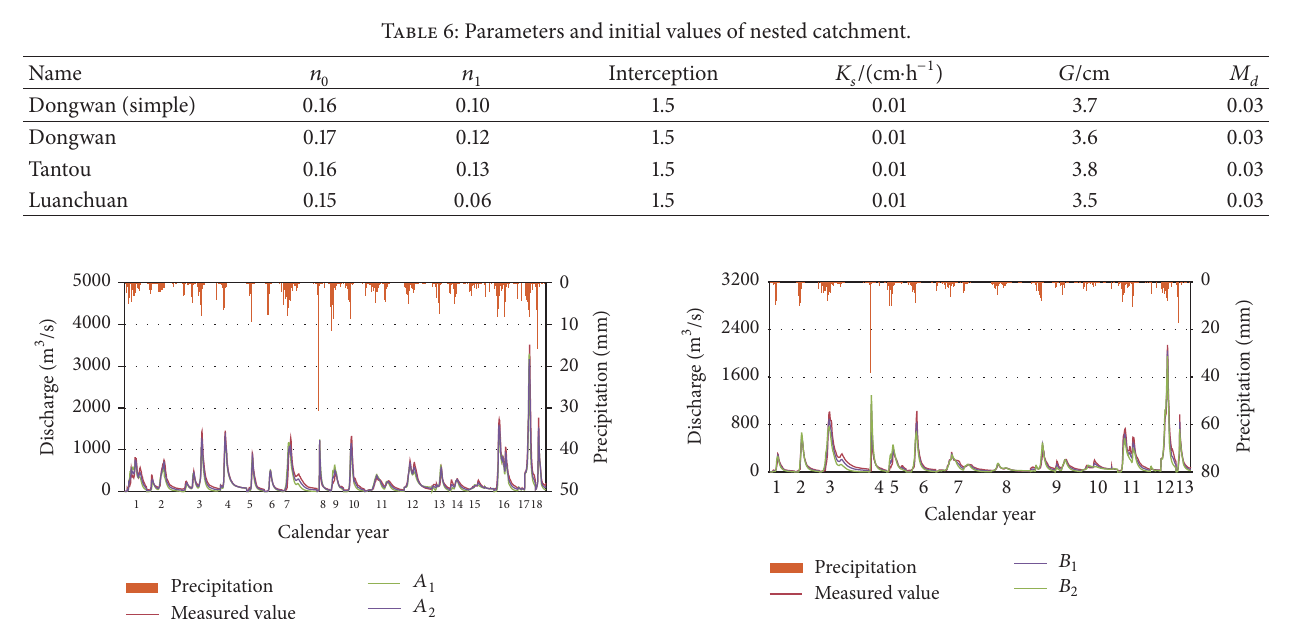
Figure 8: Comparison of the results of